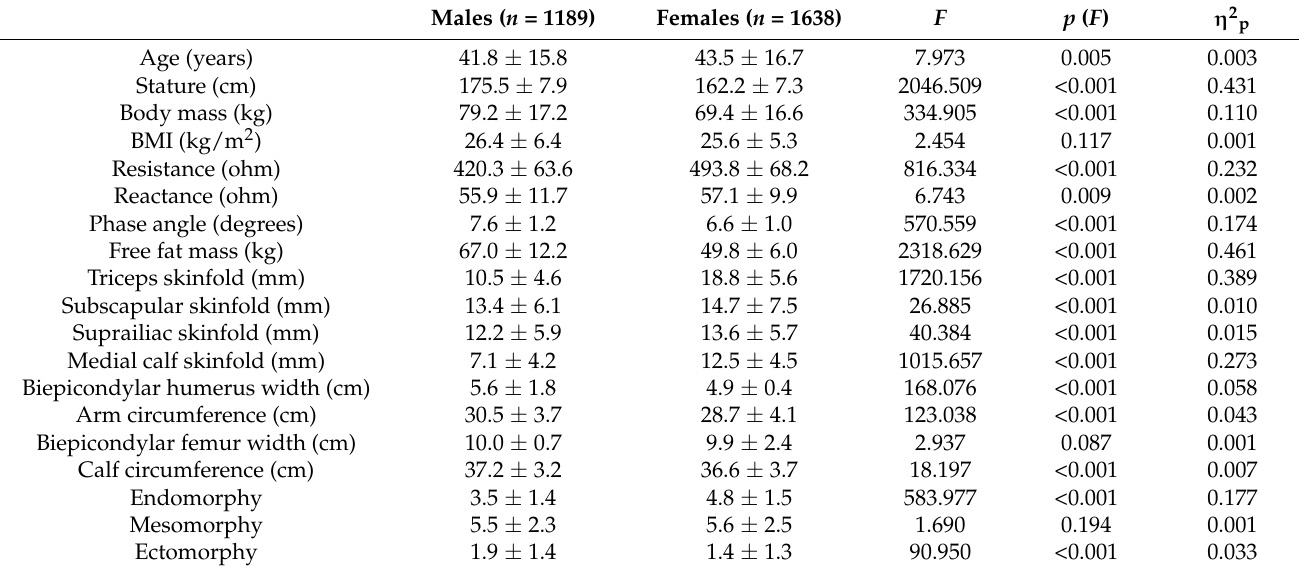
Table 1. Participants’ demographic and anthropometric